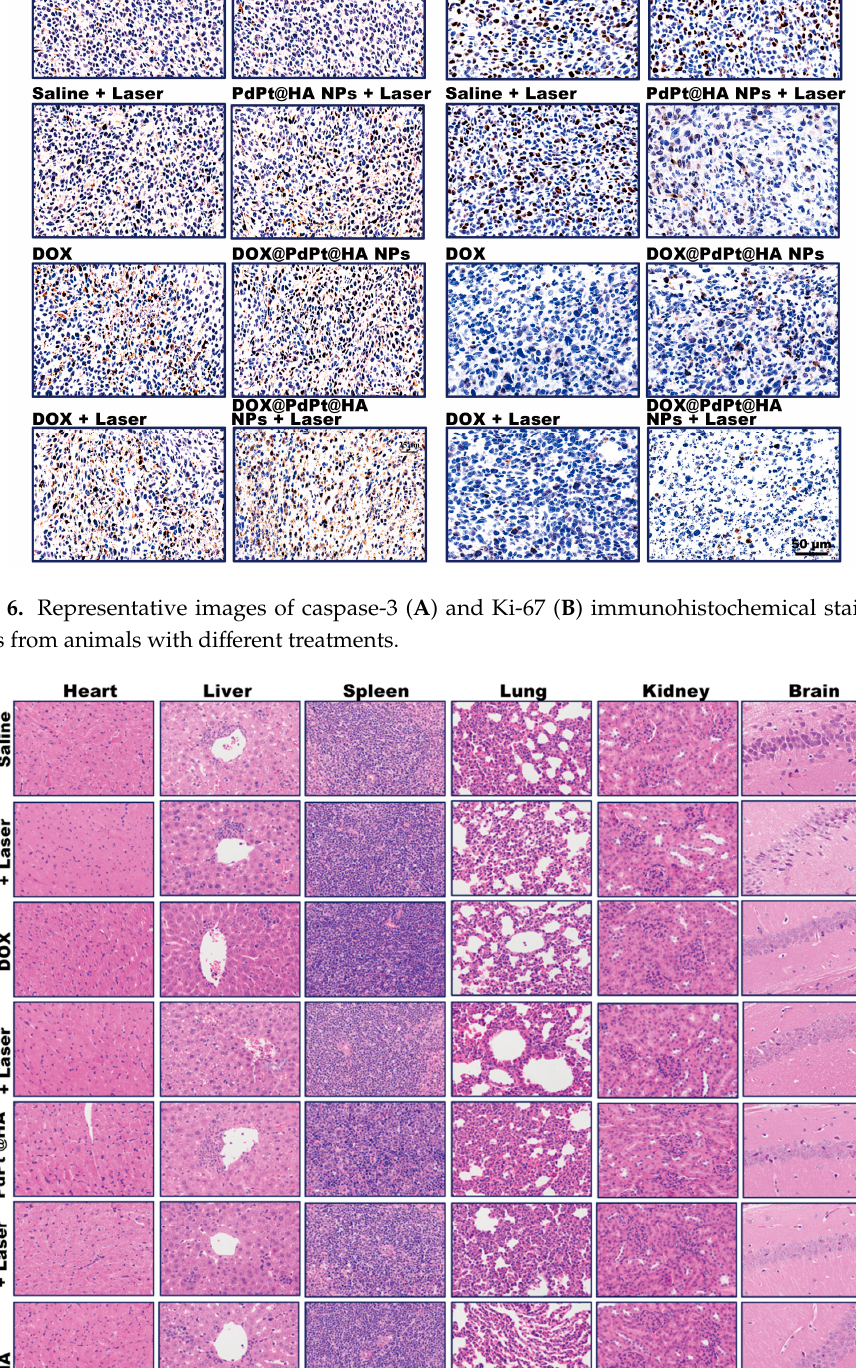
Table 1. Effects of different treatments on the organ coefficient of mice.